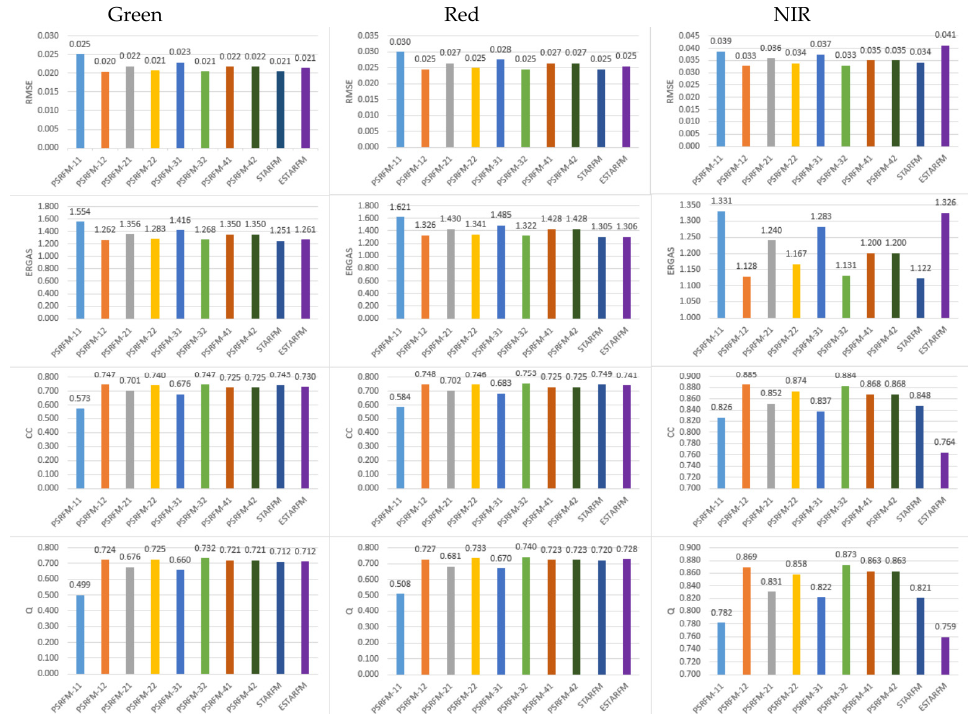
Figure 8. The quality indices of predicted reflectance by PSRFM- ij ( i = 1, 2, 3, 4; j = 1, 2), STARFM and ESTARFM against the observed reflectance on December 12 using two pairs of Landsat-5 TM and MODIS images acquired on November 26, 2004 and December 28, 2004.